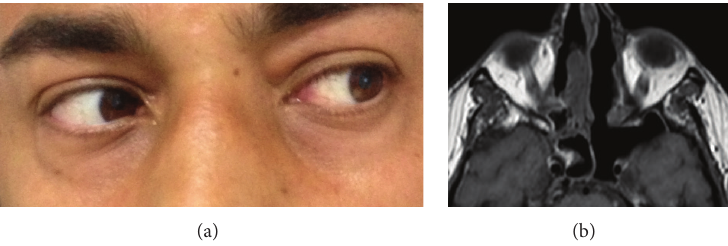
Figure 4: (a) Photo of the patient at three months after ESS showing complete recovery from left abducens nerve palsy. (b) Axial MRI performed one month after surgery. Enlargement of the left sphenoid sinus and resolution of the disease can be